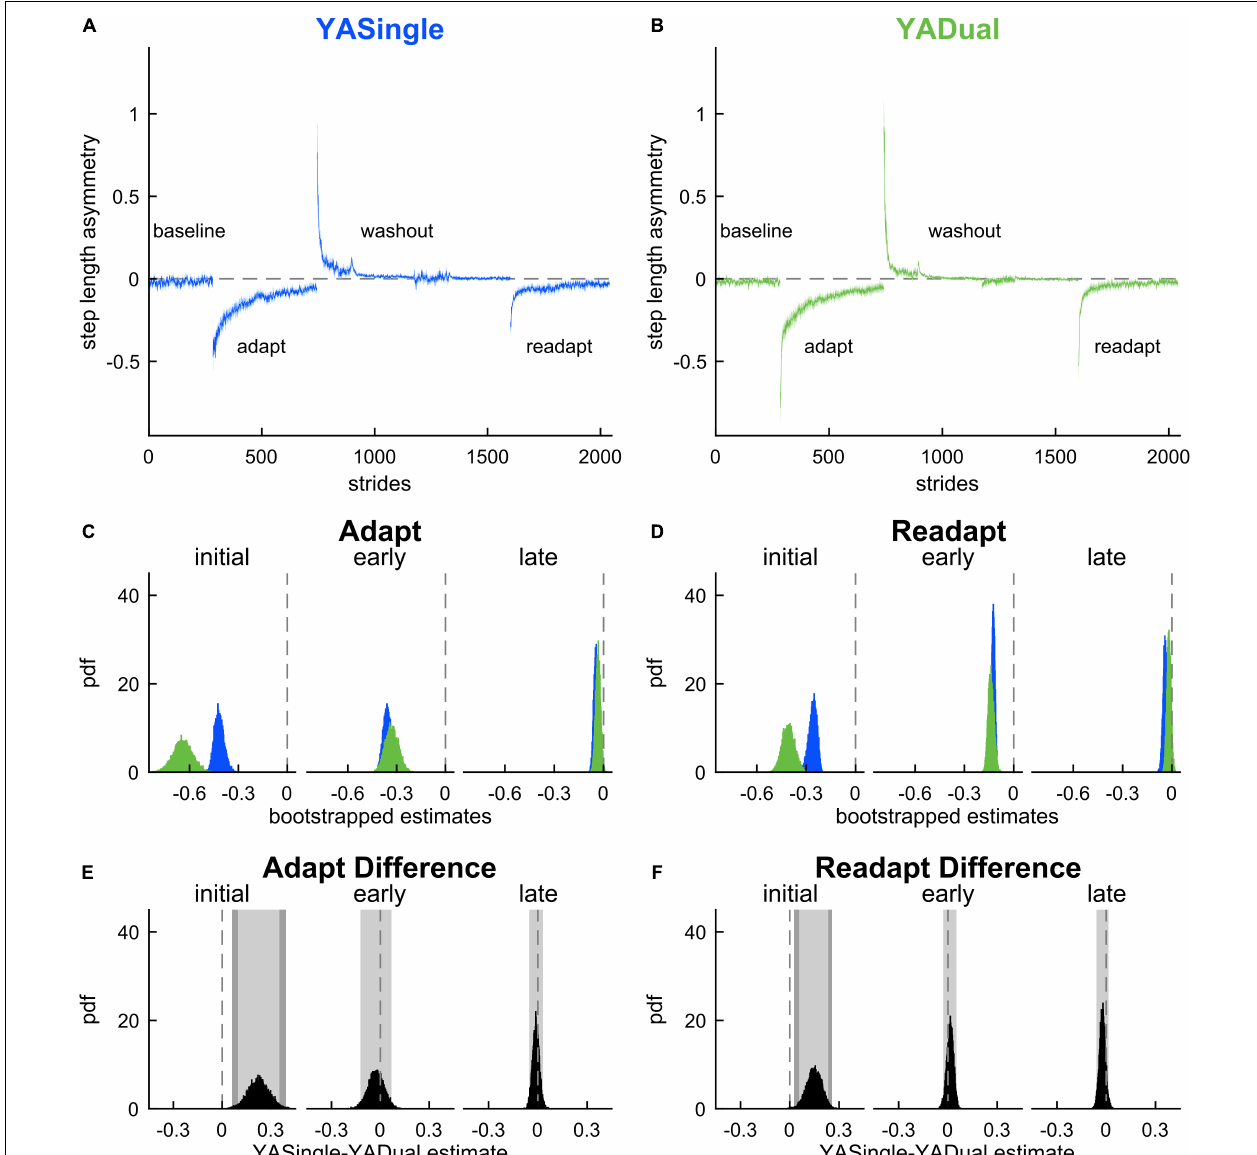
FIGURE 3 | Motor adaptation and readaptation in single- and dual-tasking young adults. Step length asymmetry time course (mean and shaded SE) for (A) single-tasking (YASingle, blue) and (B) dual-tasking (YADual, green) young adults. (C) PDF of adaptation time epochs: initial (strides 1–5), early (strides 6–30), late (last 30 strides). (D) PDF of the same time epochs in readaptation. (E) PDF of the difference of the means between YASingle and YADual for adaptation time epochs. (F) PDF of the difference of the means between YASingle and YADual for readaptation time epochs. Lighter shaded areas of PDF plots indicate the 95% CI; when applicable, darker shaded areas of PDF plots indicate the correction to the CI for 10 comparisons. PDFs and CIs were obtained through bootstrapping. Initial adaptation and readaptation were more negative in dual- than single-tasking young